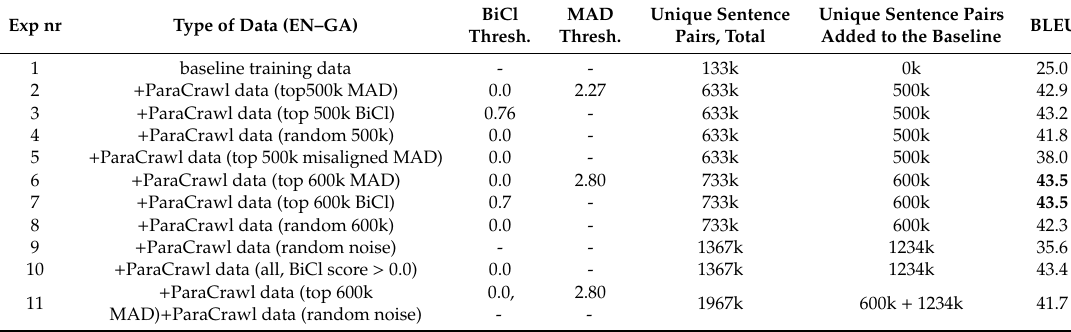
Table 7. Extrinsic evaluation of MAD and BiCleaner (EN–GA) with highest scores shown in